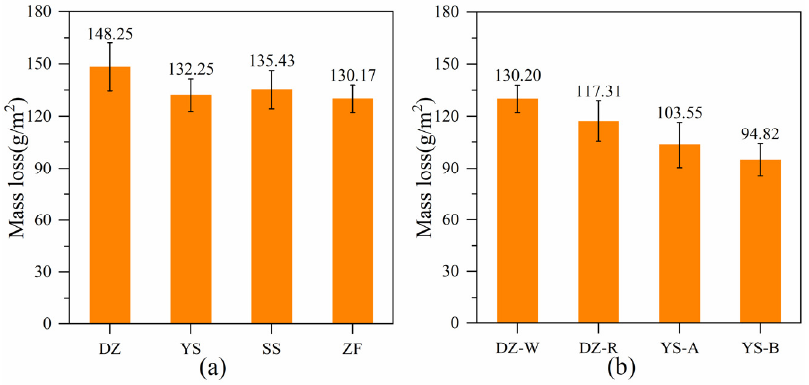
Figure 14. The effect of macroscopic surface shapes ( a ) and surface treatment ( b ) on the mass loss of PDSs. The PDSs in ( a ) were made of 45# steel while those in ( b ) were made of 65Mn# steel.